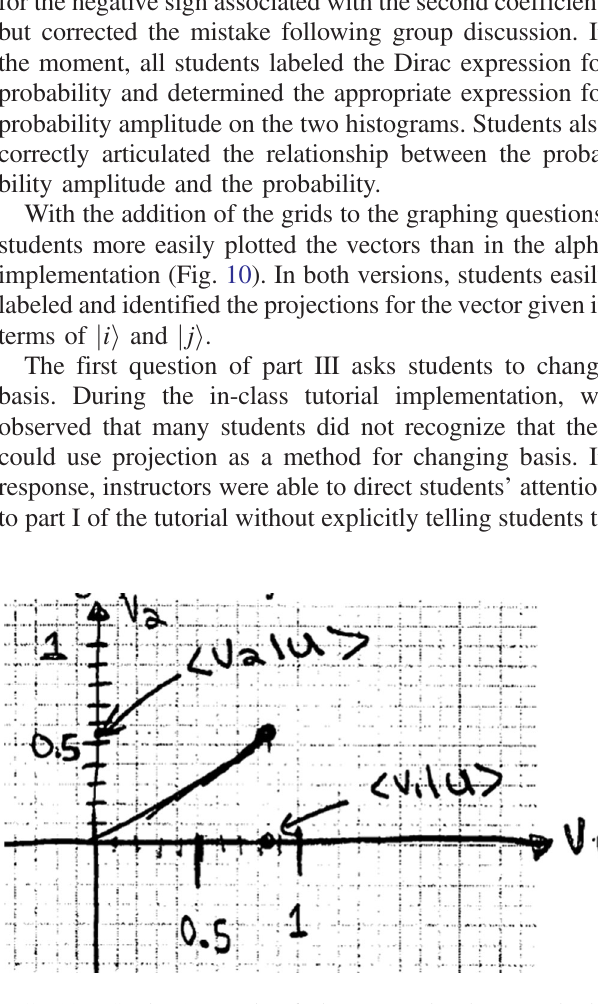
FIG. 11. Student work where both sets of basis vectors are drawn as the horizontal and vertical axes. Here the student incorrectly equates the unit